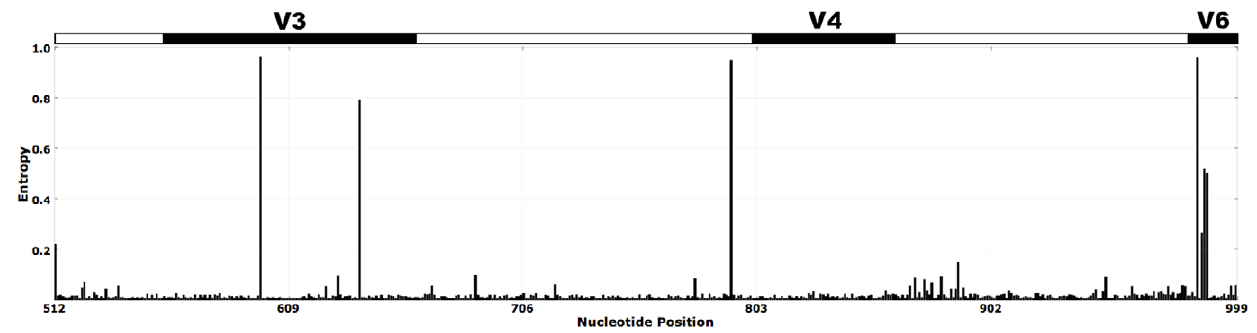
Figure 1. Shannon entropy analysis per column for 65,710 aligned G.vaginalis sequences. Peaks in entropy indicate nucleotide variation at given locations. While the X-axis of the figure indicates the location of the given column in the full length G. vaginalis 16S rRNA gene sequence, bar at the top superimposes the approximate locations of hyper-variable regions V4 (557–662), V5 (800–861) and V6 (981–1027) on G. vaginalis sequences that were used in this study.